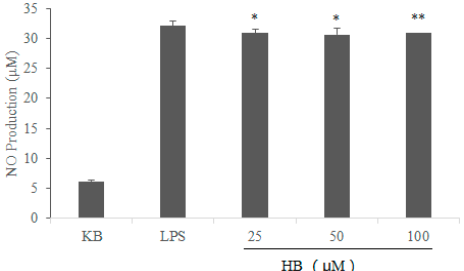
Figure 3. Effects of HB on LPS-induced NO production in RAW 264.7 Cells. RAW 264.7 Cells were pretreated with different concentrations of HB (25, 50, and 100 μ M) for 1 h before treatment with 1 μ g/mL LPS. After incubation for 18 h, the NO production analysis was detected by Griess test. The values are presented as means ± SD of three independent experiments. * p < 0.05, ** p < 0.01, compared to the LPS-treated group.